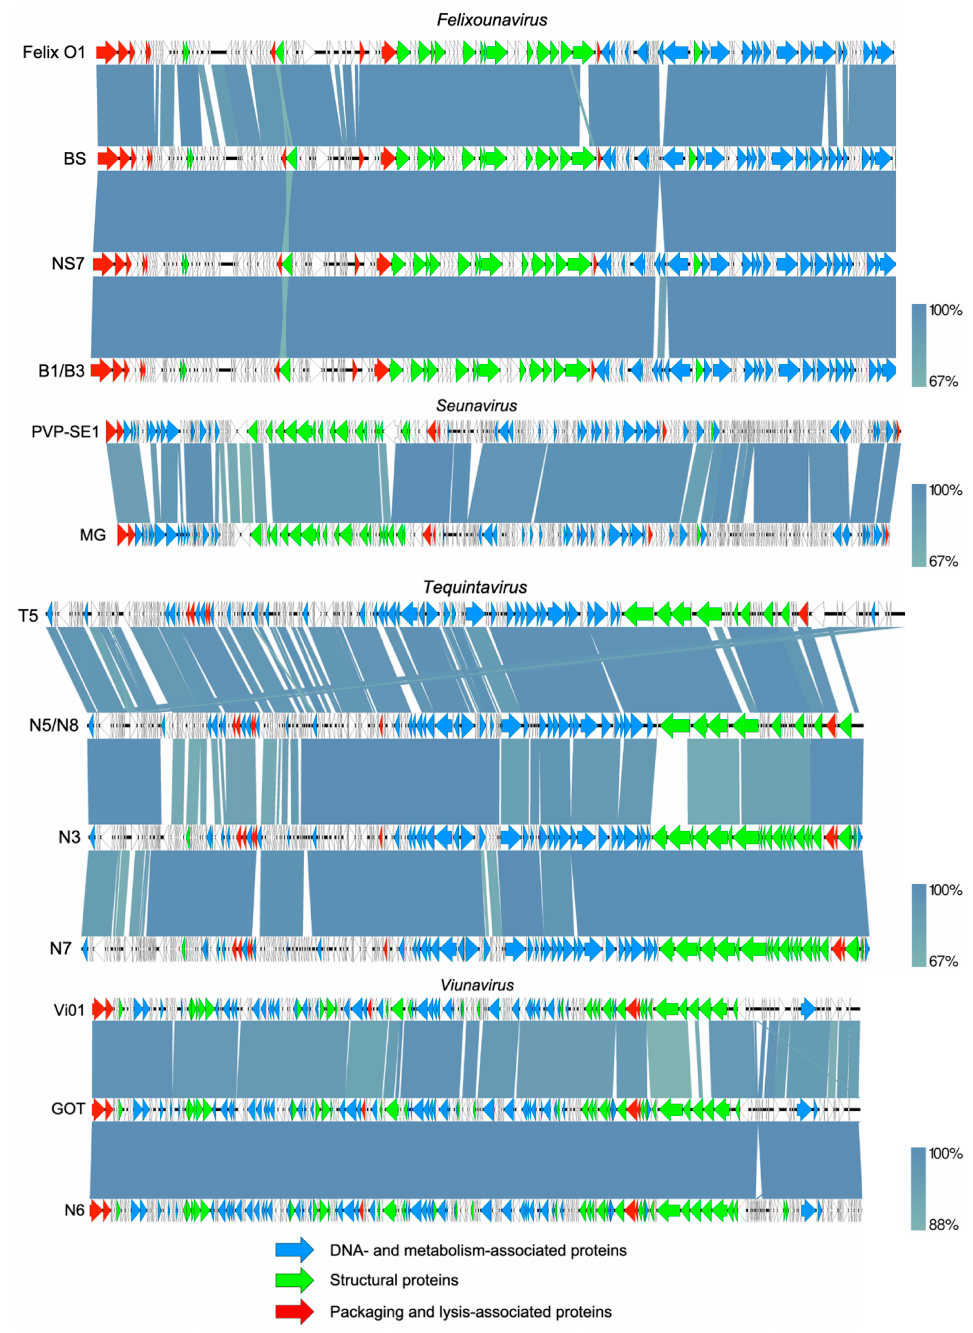
Figure 5. Genome maps of the sequenced Salmonella phages and comparison using a BLASTn analysis. The phages can be classified in four different genera: Felixounavirus (GEC_vB_BS, GEC_vB_NS7, GEC_vB_B1 and GEC_vB_B3), Seunavirus (GEC_vB_MG), Tequintavirus (GEC_vB_N5, GEC_vB_N8, GEC_vB_N3 and GEC_vB_N7) and Viunavirus (GEC_vB_GOT and GEC_vB_N6). In red, genes encoding packaging and lysis-associated proteins are displayed, in green structural proteins and in blue DNA- and metabolism-associated proteins (adapted EasyFig). Each white or colored arrow represents a predicted open reading frame. Members of the Tequintavirus contain direct terminal repeats (DTR) of approximately 10 kb for their packaging strategy, which can be observed by the homology of the last part of the T5 genome to the start of the N5/N8 genomes. For visibility reasons, these redundant DTR regions were deleted from the Genbank files and the figure.